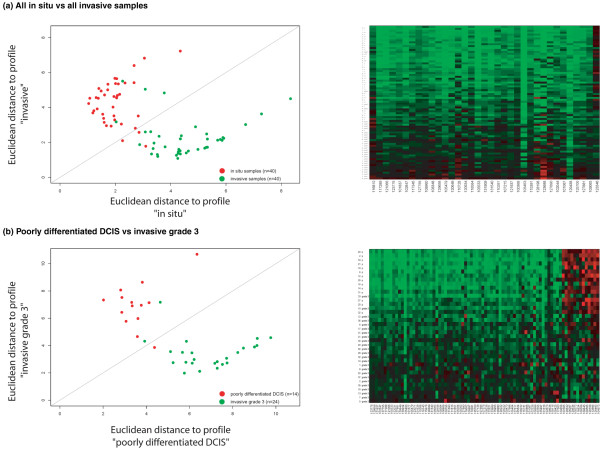
Euclidean distance and heatmaps of the in situ and invasive samples using the classifiers obtained after cross-validation. (a) All ductal carcinoma in situ (DCIS) (n = 40) and all invasive (n = 40) samples. The classifiers consist of 80 genes. (b) Poorly differentiated DCIS (n = 14) versus invasive grade 3 samples (n = 24) using a classifier of 35 genes. p, poorly differentiated.